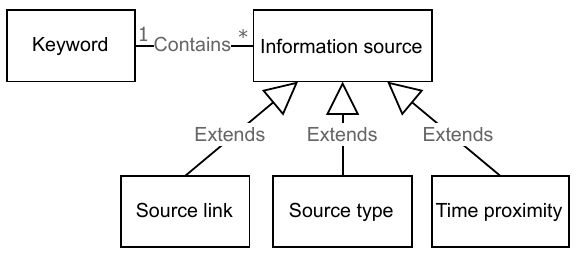
Figure 6. Metamodel of the collected information